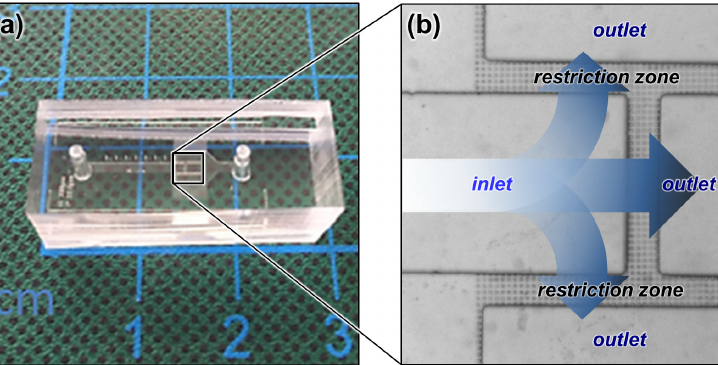
Figure 2. ( a ) Microfluidic photoreactor photograph; ( b ) optical microscopy image of the restriction zone.